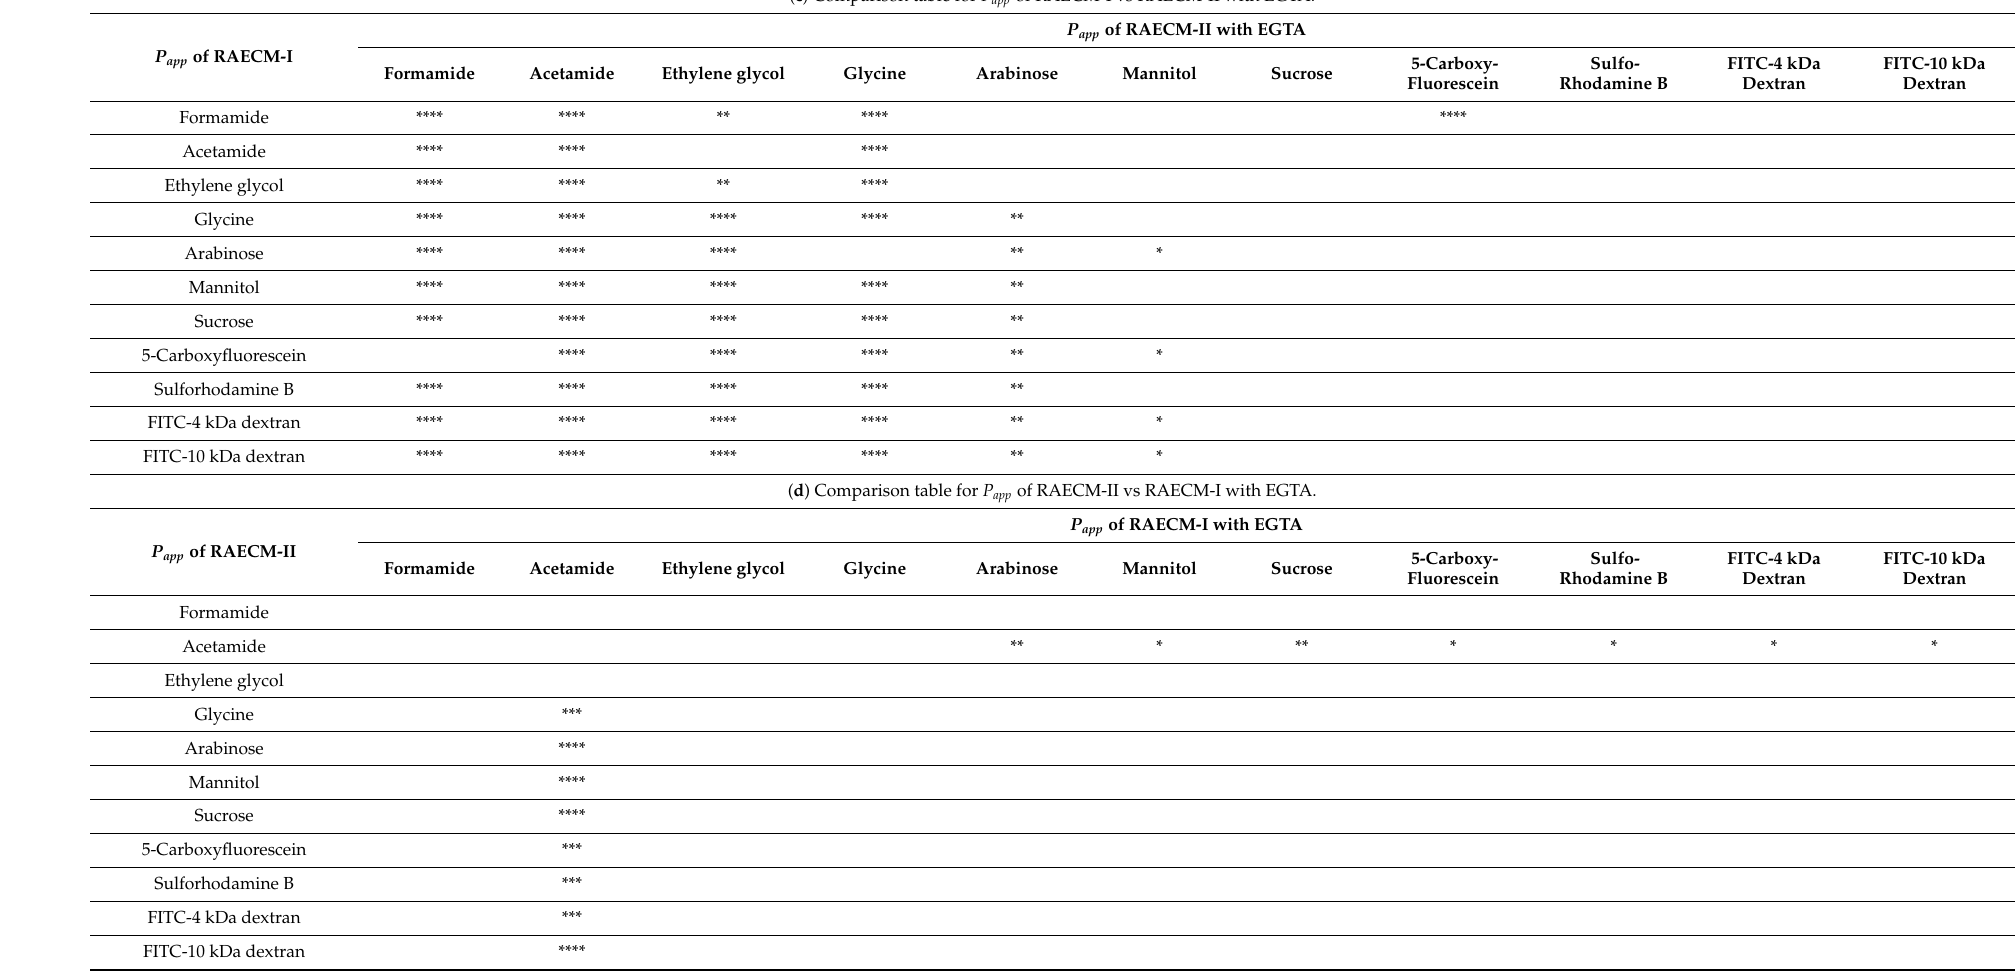
Table A2. Cont. ( c ) Comparison table for P app of RAECM-I vs RAECM-II with EGTA.